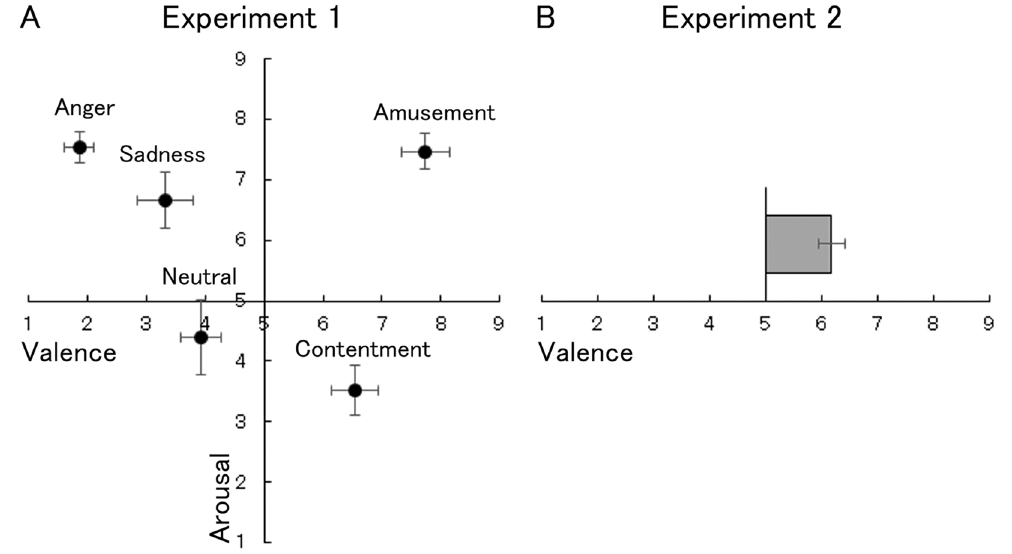
Figure 3. Mean (with SE ) overall ratings in Experiments 1 ( A ) and 2 ( B